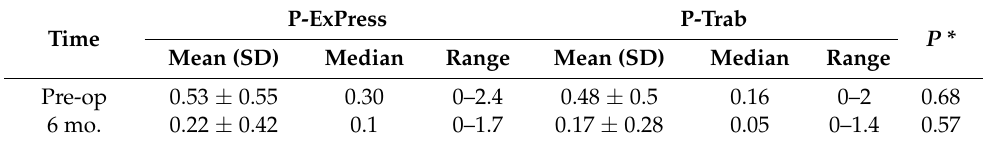
Table 4. Visual acuity (logMAR) mean values, median values, standard deviations, and ranges in the phaco-ExPress (P-ExPress) and phaco-trabeculectomy (P-Trab) groups before and 6 months after